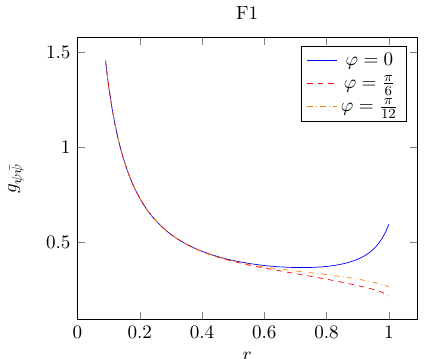
Figure 6 . Metric for constant ’ -values in the pseudo-hybrid phase of F1.